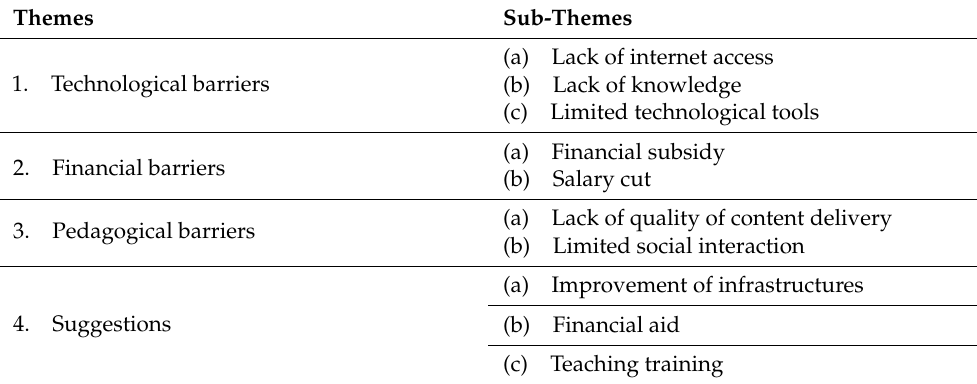
Table 2. Themes and